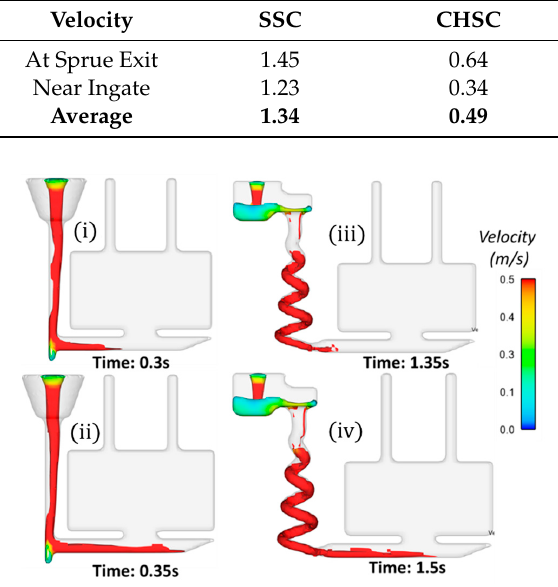
Figure 3. Simulation-based metal flow at two different instances filling the runner in ( i, ii ) straight sprue casting (SSC) and ( iii, iv ) conical-helix sprue casting (CHSC).